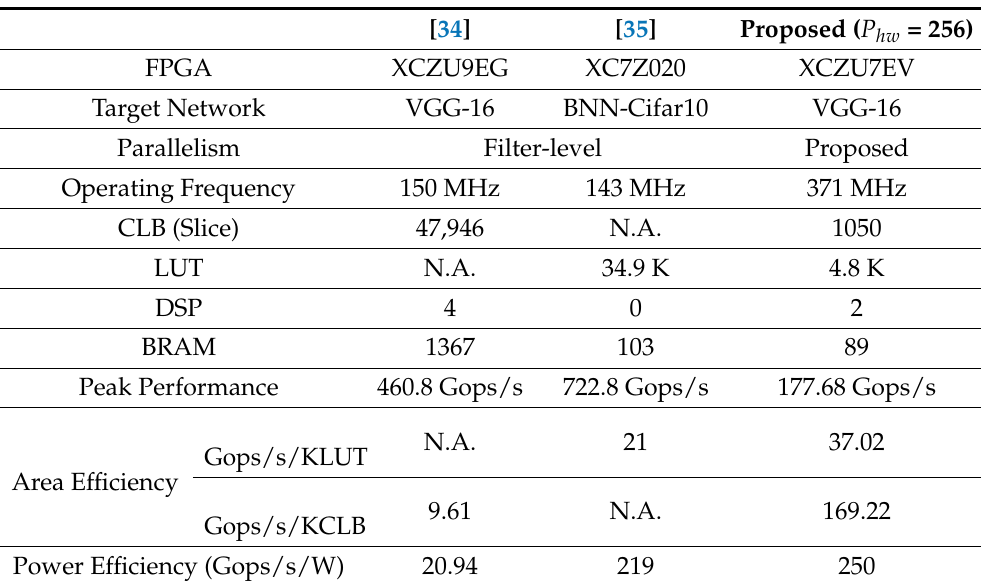
Table 3. Comparison of the FPGA implementation results of our accelerator with previous works. CLB, configurable logic